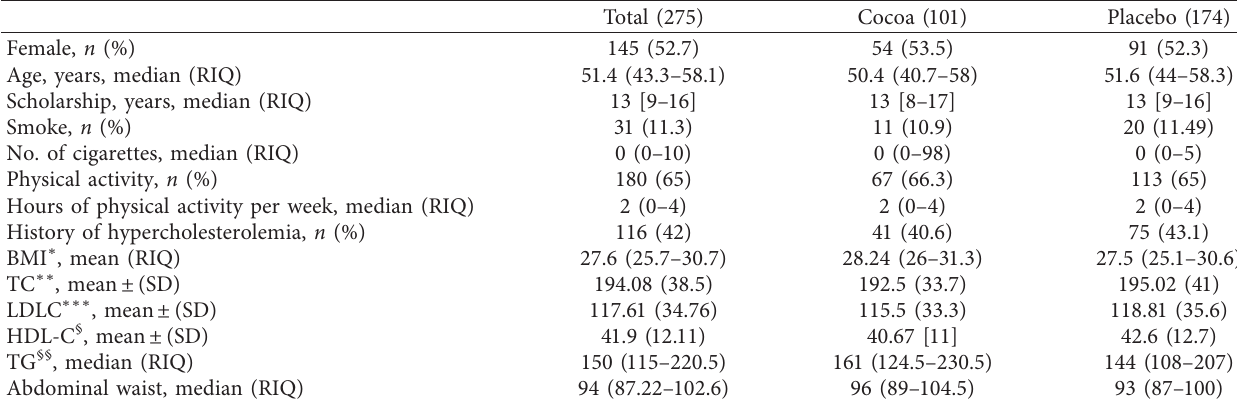
Table 1: Characteristics of the study population, presented according to the distribution of the variable. Total (275)